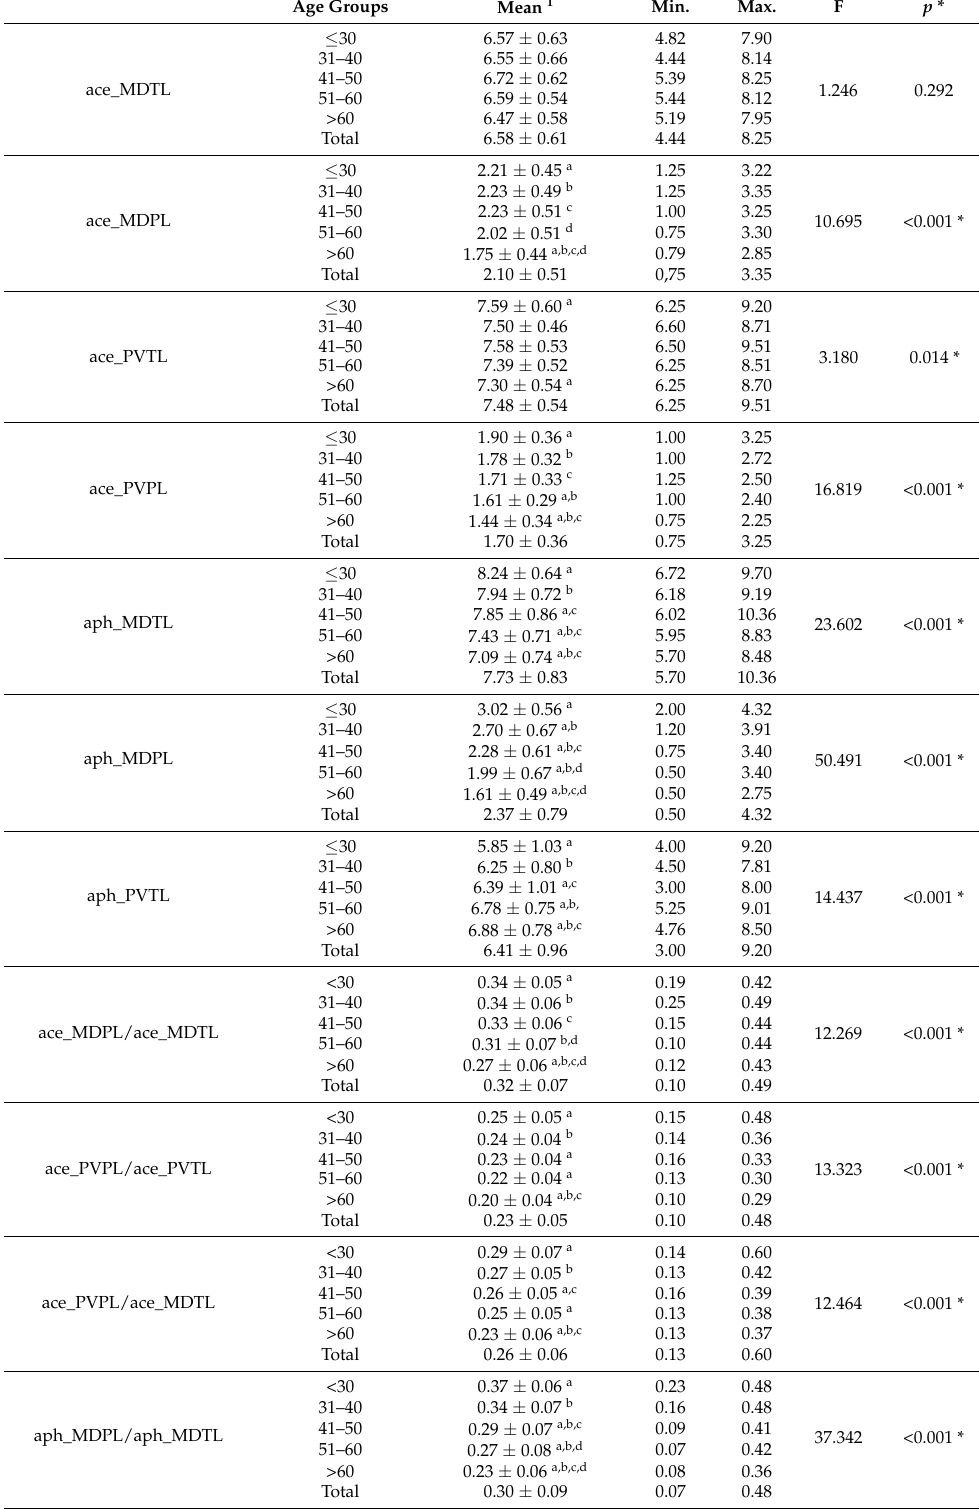
Table 3. Differences in axial linear measurements and ratios between age